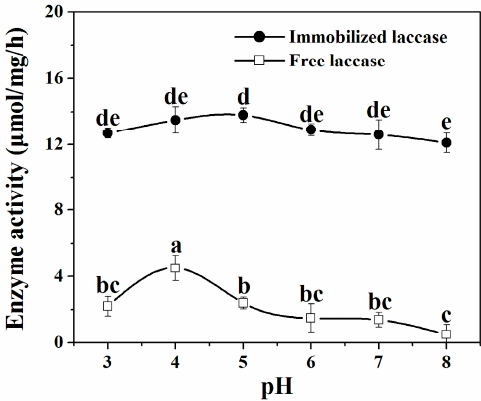
Figure 4. Effect of pH on the enzyme activity of laccase and laccase in the nanoflowers. Reaction